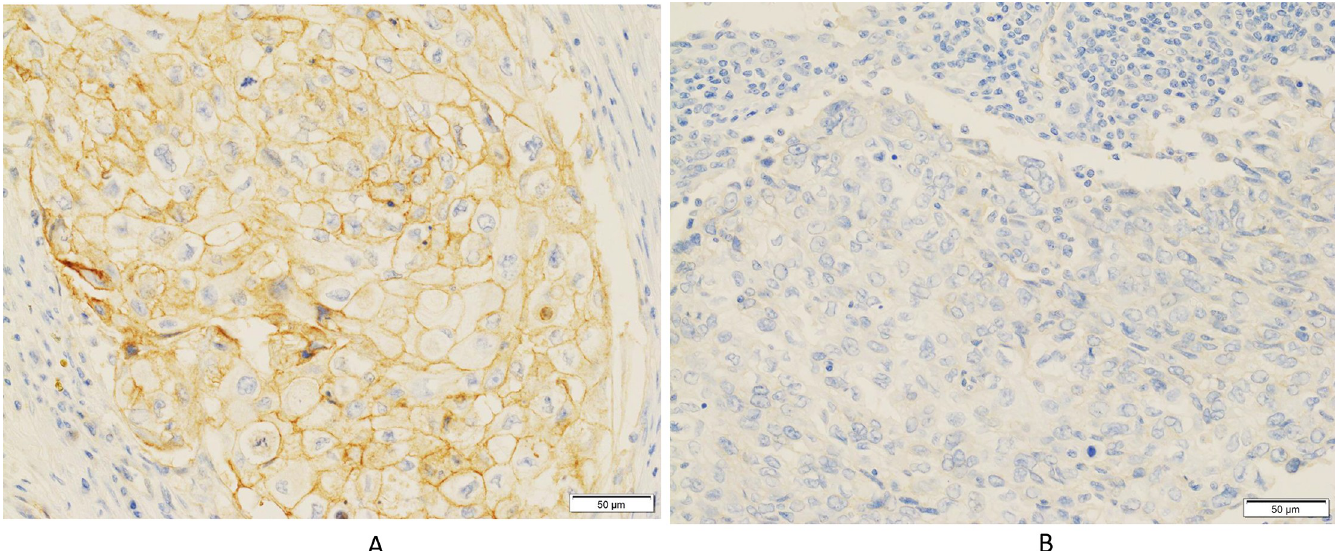
Fig 1. Immunohistochemical Staining for CD155 in patients with triple-negative breast cancer. ( A ) Complete and strong membranous immunoreactivity in tumor cells ( × 400). ( B ) No immunoreactivity in tumor cells ( ×